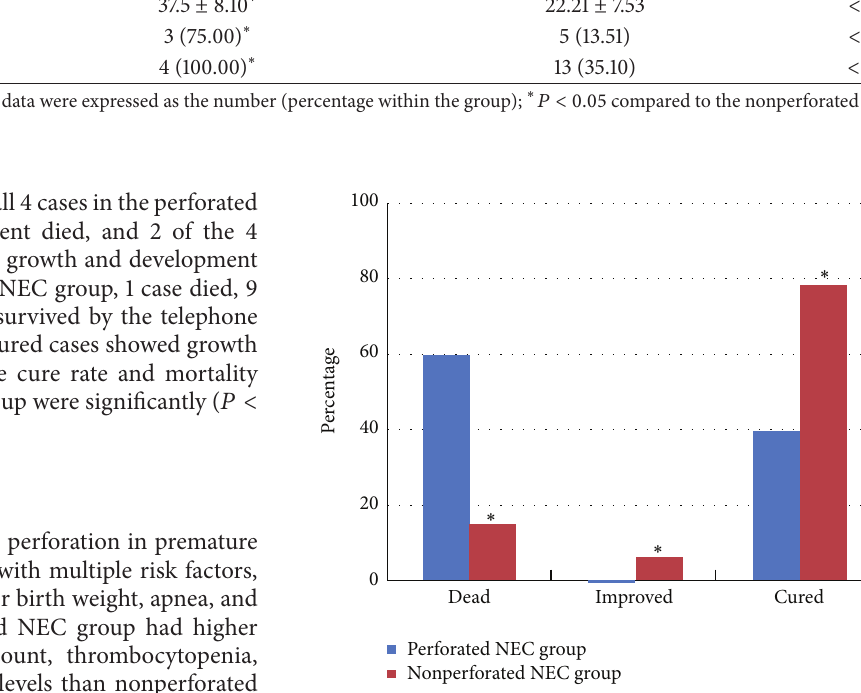
Figure 1: Clinical outcomes of NEC infants with and without bowel perforation. ∗ 𝑃 < 0.05 compared to the nonperforated NEC group. “Cured” means complete functional recovery to a healthy state, while “Improved” means partial functional recovery with symptoms ameliorated, while some organ dysfunctions may